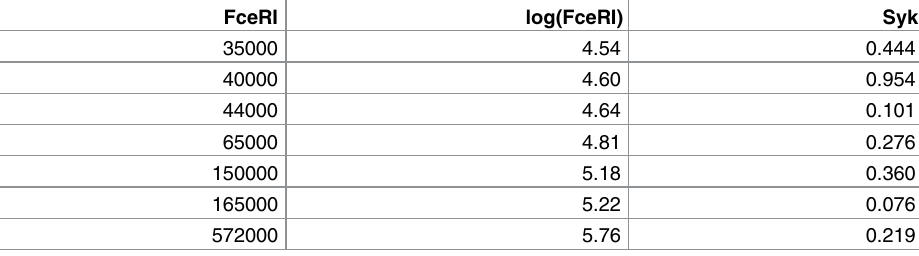
Table 2. A single example of FceRI expression vs. syk expression(in units of Western blot